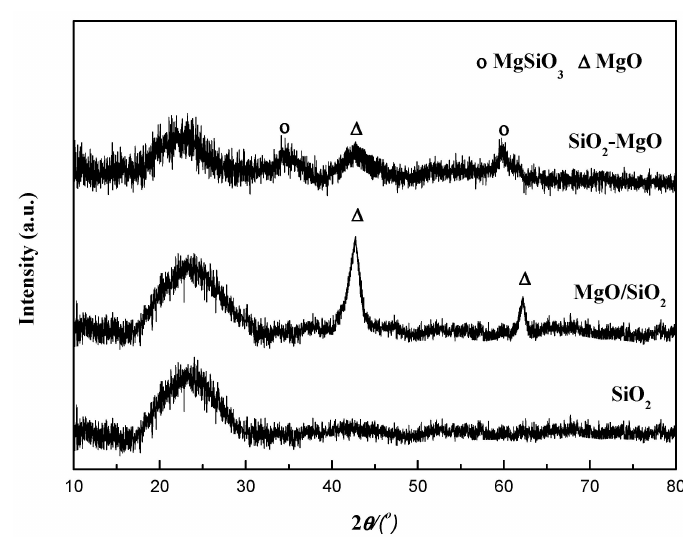
Figure 1. XRD patterns of the supports.